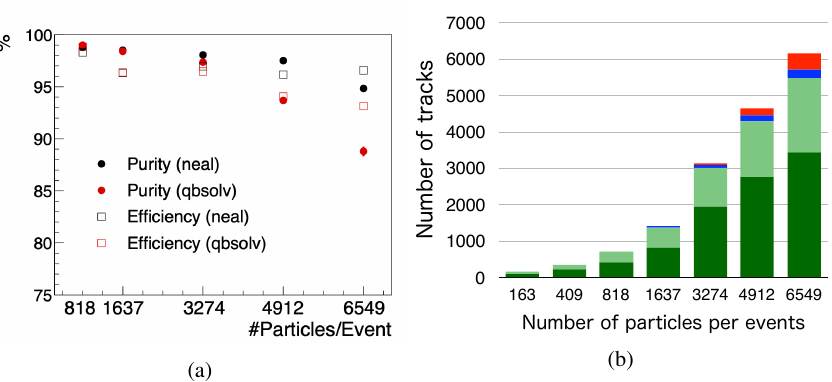
Figure 3: (a) Purity (circle) and e ffi ciency (square) as a function of the number of particles. Black (red) shows the results by neal (qbsolv) solver. (b) The number of tracks of each categories. Tracks are reconstructed from connected doublets. If a track contains less than five doublets, the track is rejected. A coloring is defined in a similar way in Figure